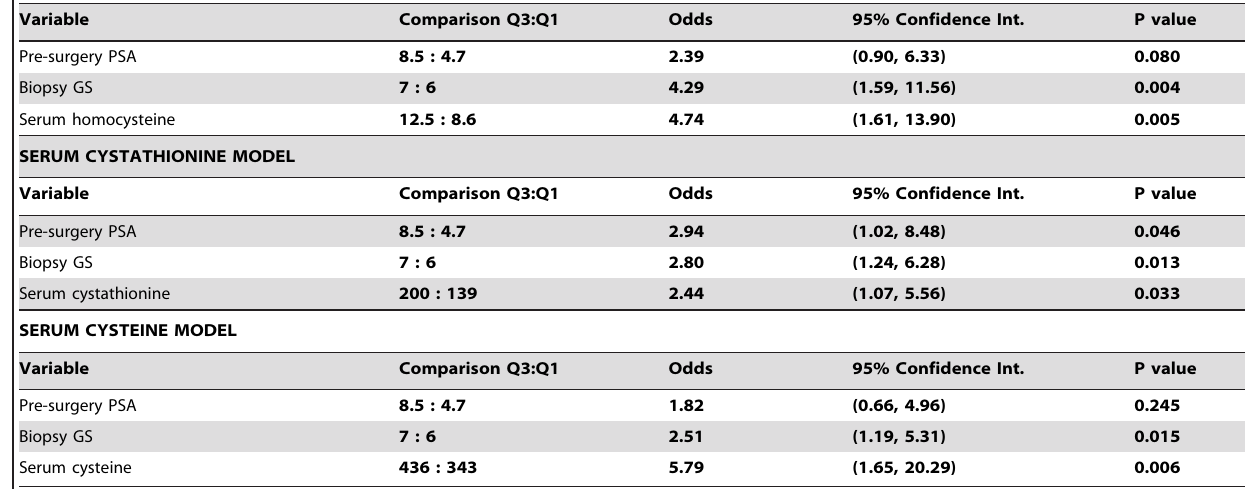
Table 5. Logistic regression models.